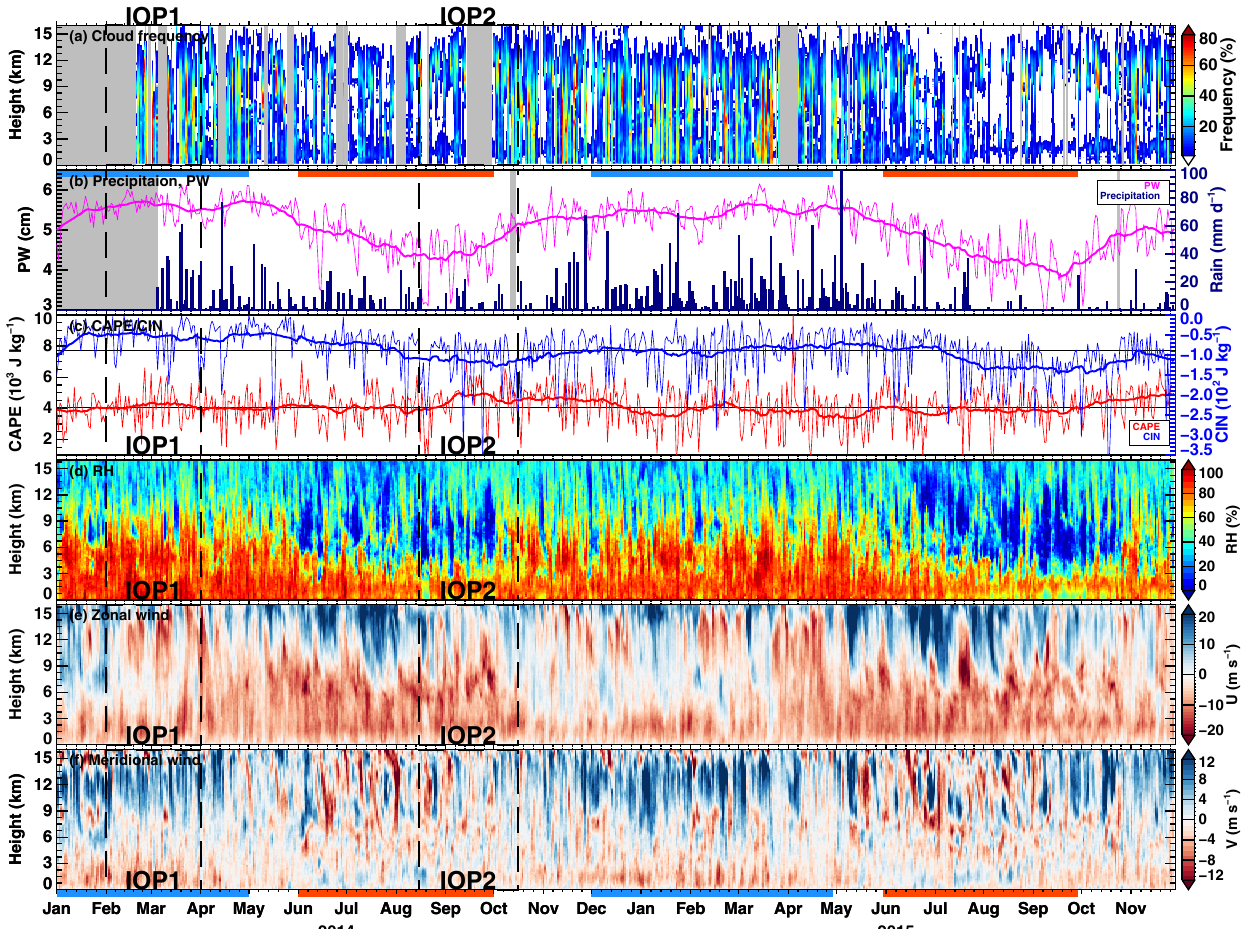
Figure 2. Time series of (a) cloud frequency from the merged WACR-ARSCL-RWP dataset, (b) column precipitable water (purple; thick line is the 30-day running mean) and surface precipitation (dark blue bars), sounding measurements of (c) daily maximum CAPE (red), daily minimum CIN (blue), two horizontal lines are their respective mean values, (d) relative humidity (with respect to liquid), (e) zonal wind and (f) meridional wind. The data shown are daily average values. Gray fillings in panels (a, b) are periods with missing cloud or precipitation data, respectively. “Wet” and “dry” seasons in this study are denoted with blue and orange bars in panels (b, f) ; IOP1 and IOP2 periods are denoted by the vertical dash